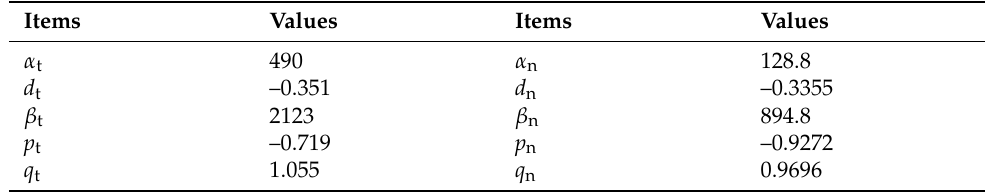
Table 1. Values of cutting coefficient for Al6061-T6.